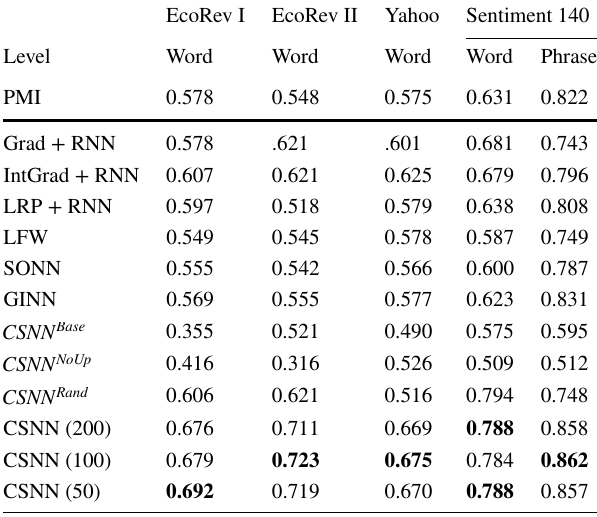
Table 6 Evaluation for explanation ability in WCSL (Macro F 1